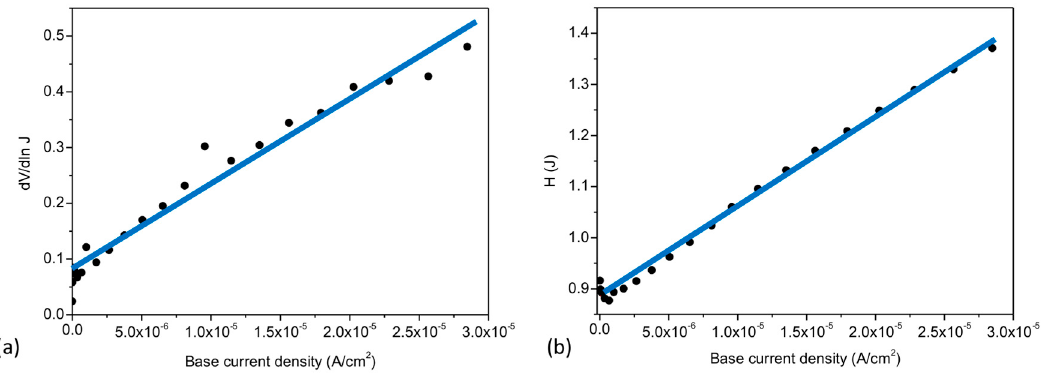
Figure 3. ( a ) (cid:1856)(cid:1848)/(cid:1856)(cid:1864)(cid:1866) (cid:1836) versus (cid:1836) and ( b ) (cid:1834)(cid:4666)(cid:1836)(cid:4667) versus (cid:1836) plot of the forward-bias output characteristics Figure 3. ( a ) dV / dln J versus J and ( b ) H ( J ) versus J plot of the forward-bias output characteristics of of the BE interface. the BE